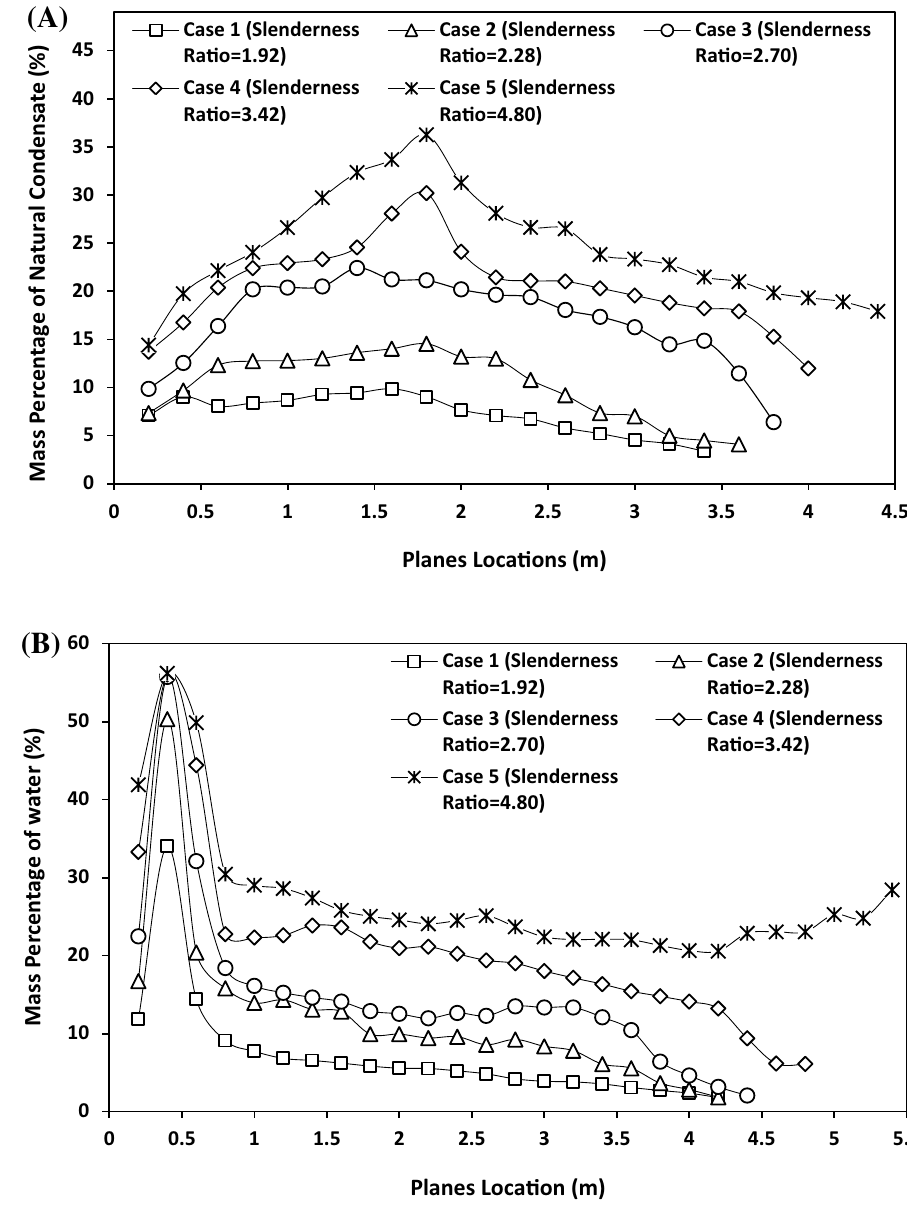
Fig. 15 Simulated mass dis- tribution of condensate in the water zone ( a ) and water in the condensate zone ( b ) of Cases